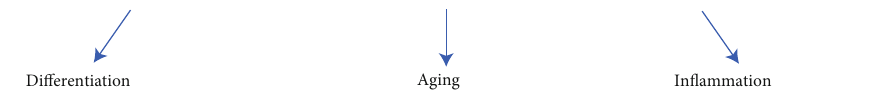
Figure 1: Amino acids, glucose, and fatty acids are utilized by metabolic pathways including one carbon metabolism, glycolysis, TCA cycle, and fatty acid catabolism. Metabolic intermediates generated from cellular metabolic pathways are substrates, cofactors, or antagonists for enzyme activity in epigenetic events including methylation, demethylation, acetylation, and deacetylation. These metabolic-sensitive epigenetic events are involved in the transcriptional program alteration and drive the dental mesenchymal stem cells into di ff erentiation, aging, or in fl ammatory responses. SAM: S-adenosylmethionine; SAH: S-adenosylhomocysteine; acetyl-CoA: acetyl coenzyme A; SucCoA: succinyl-CoA; 2-HG: 2-hydroxyglutarate; α KG: α -ketoglutarate; TCA cycle: tricarboxylic acid cycle; NAD: nicotinamide adenine dinucleotide; FAD: fl avin adenine dinucleotide; DNMTs: DNA methyltransferases; HMTs: histone methyltransferases; METTL3: methyltransferase-like 3; TETs: ten-eleven translocations; KDMs: histone lysine demethylases; HATs: histone acetyltransferases; HDACs: histone